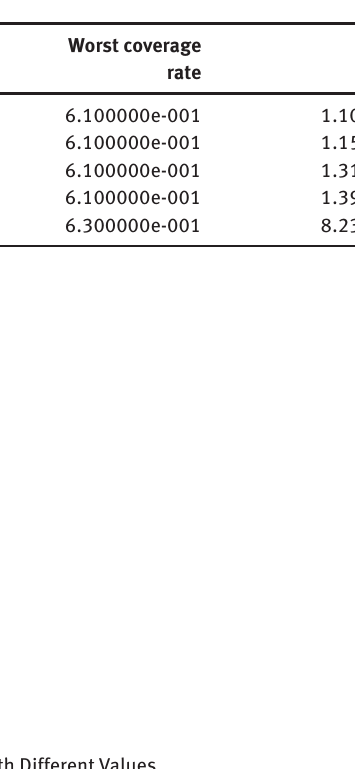
Figure 5: The Coverage Rate Curves When the Iteration Number Was Set with Different Values.